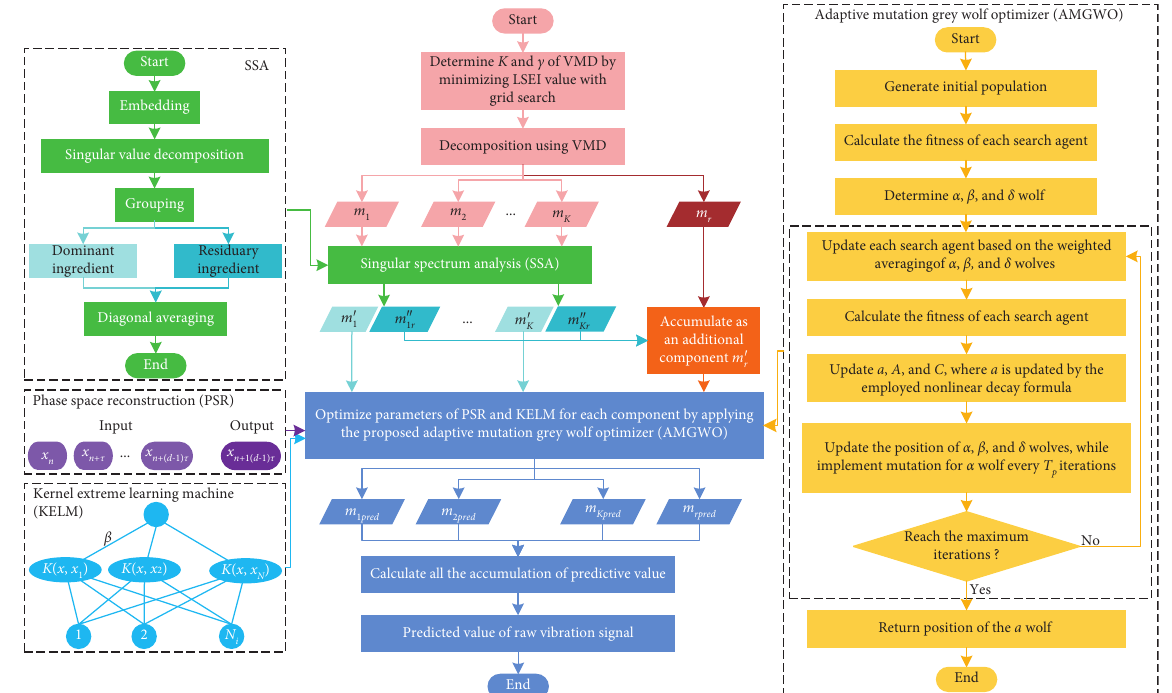
Figure 5: The procedures of the proposed approach for vibration tendency prediction.